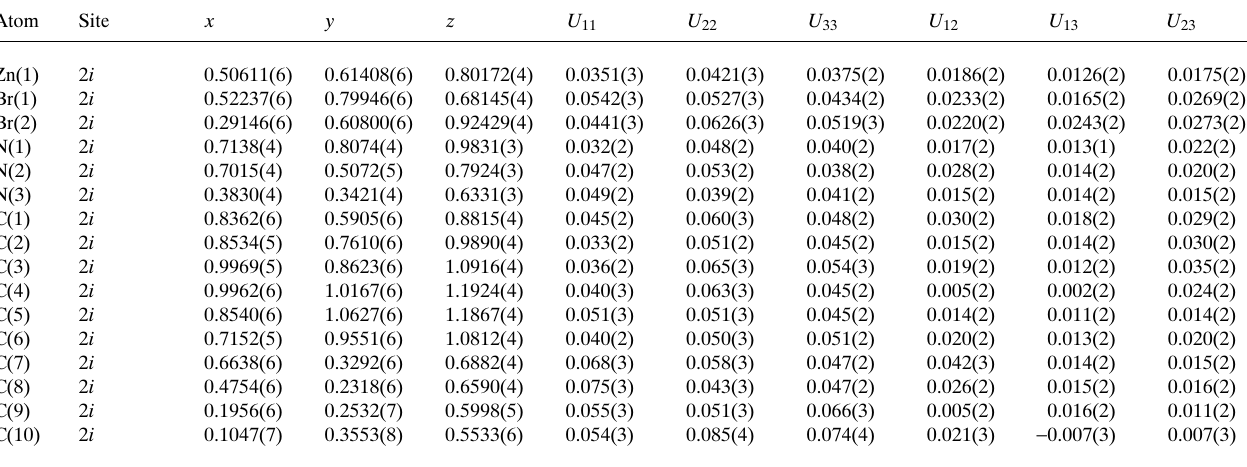
Table 3. Atomic coordinates and displacement parameters (in Å 2 )